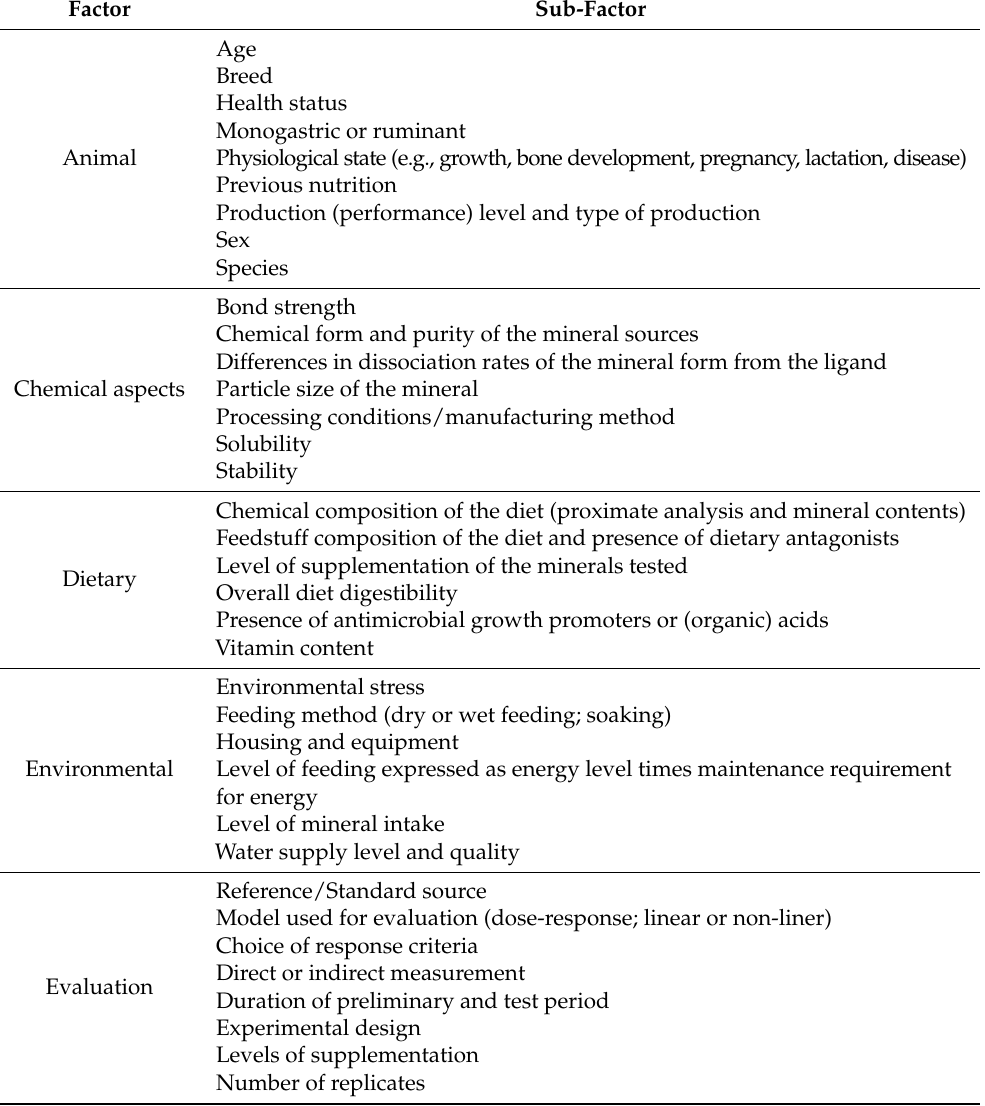
Table 3. Factors affecting bioavailability in production